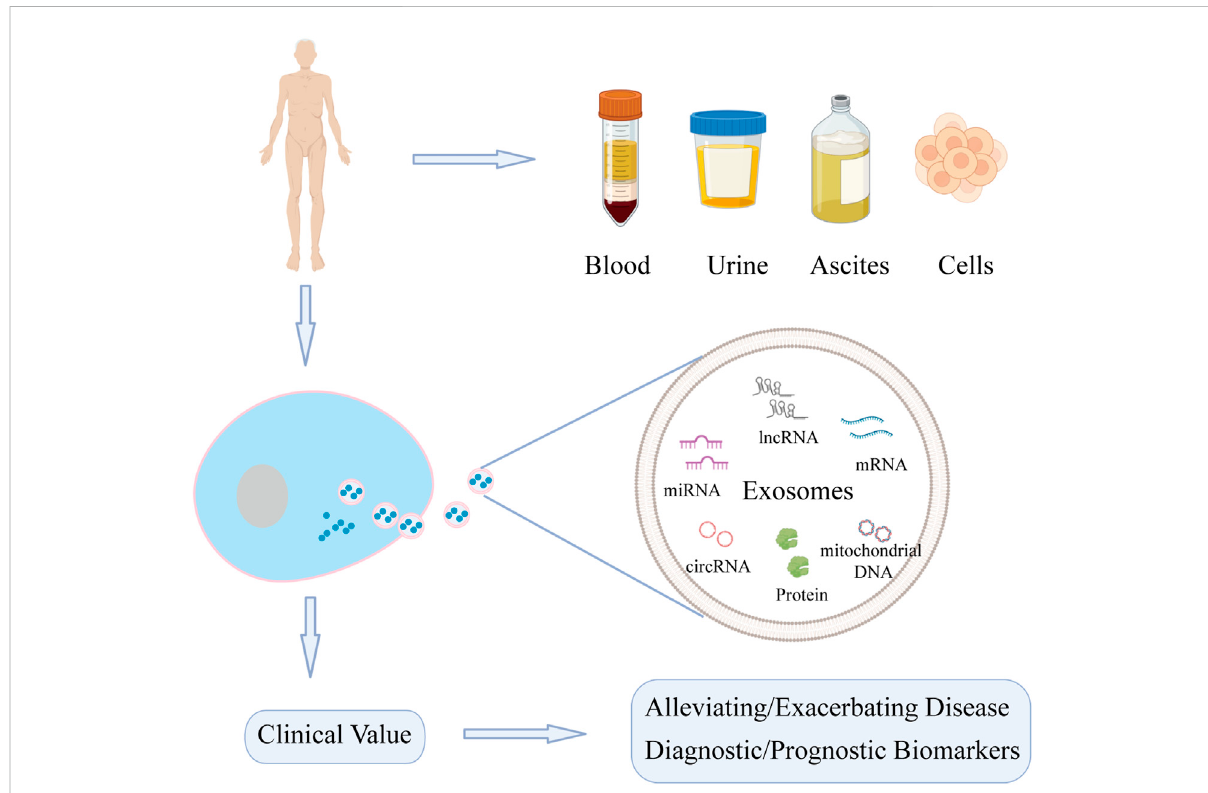
FIGURE 1 Function of nucleic acids and proteins carried by exosomes from different sources on liver diseases. Exosomes can be extracted from various sources. Nucleic acids and proteins carried by exosomes can not only act as biomarkers for diagnosis and treatment, but also may alleviate or exacerbate liver